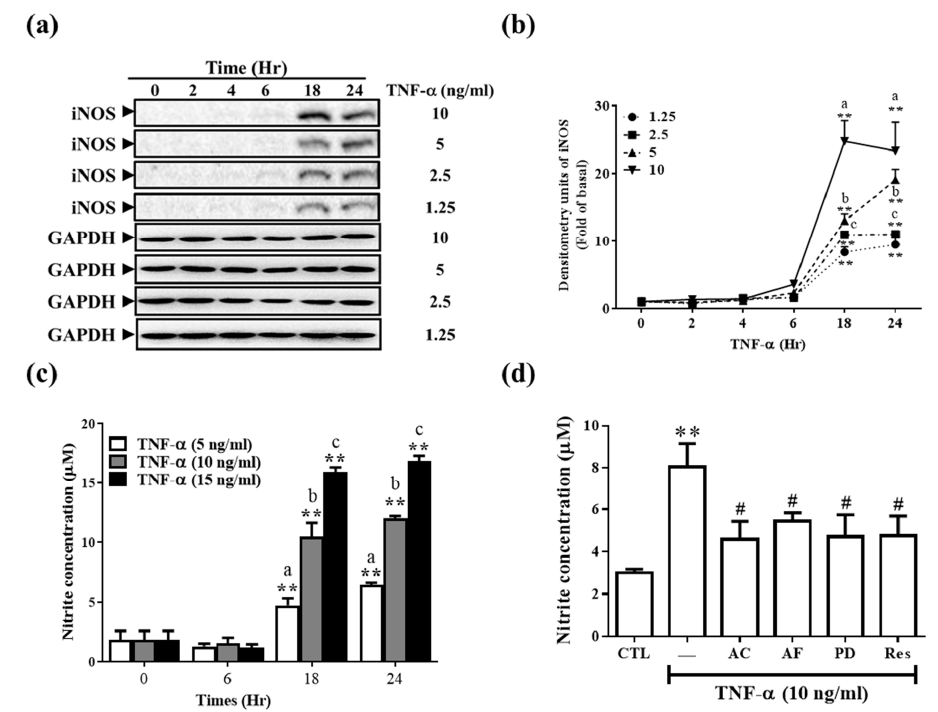
Figure 4. AC, AF, Res, and PD affected the TNF- α -induced iNOS expression and intracellular NO production. ( a , b ) TNF- α was used to stimulate RMCs at different concentrations and times. ( c ) Cells were treated with AC, AF, PD, and Res (10 µ g/mL) for 2 h and then stimulated with TNF- α for 24 h. ( a ) The cell lysate was collected, and the expression of iNOS was analyzed by Western blotting using GAPDH as a loading control. ( b ) Quantitative graph for ( a ). ( c , d ) The supernatant was collected, and the NO content was indirectly analyzed using the Griess reagent analysis method. The results are presented as the mean ± SD from 3 experiments and analyzed ( b , c ) using two-way ANOVA followed by Tukey’s multiple comparisons post hoc test. p < 0.01; different letters represent significant differences between groups and ( d ) using one-way ANOVA followed by Dunnett’s post hoc test. ** p < 0.01, compared with the untreated group. # p < 0.05, compared with the TNF- α treatment